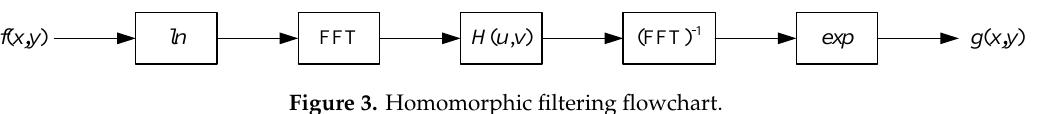
Figure 3. Homomorphic filtering flowchart.